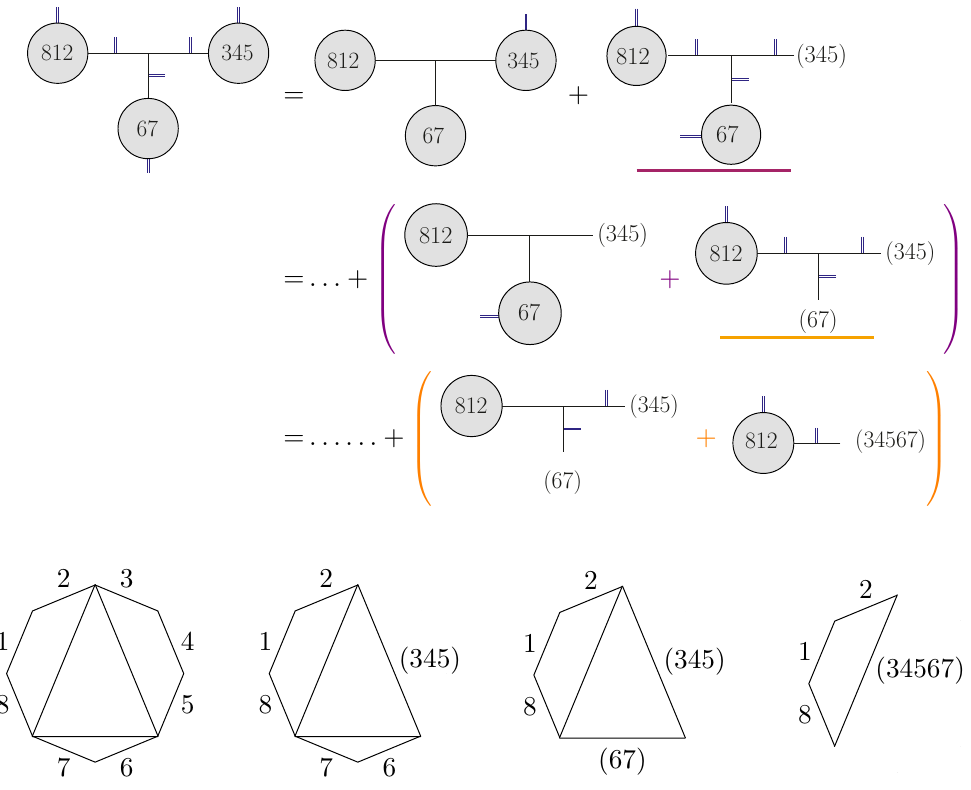
Figure 5. Feynman diagrams computed in each steps of an alternative expansion for 2 ) (8 , 1 , 2 , 6 , 7 , 3 , 4 , 5 | 1 , 2 , 3 , 4 , 5 , 6 , 7 , 8) (top), and the reduction of the mutual partial triangu- F tr( φ 8